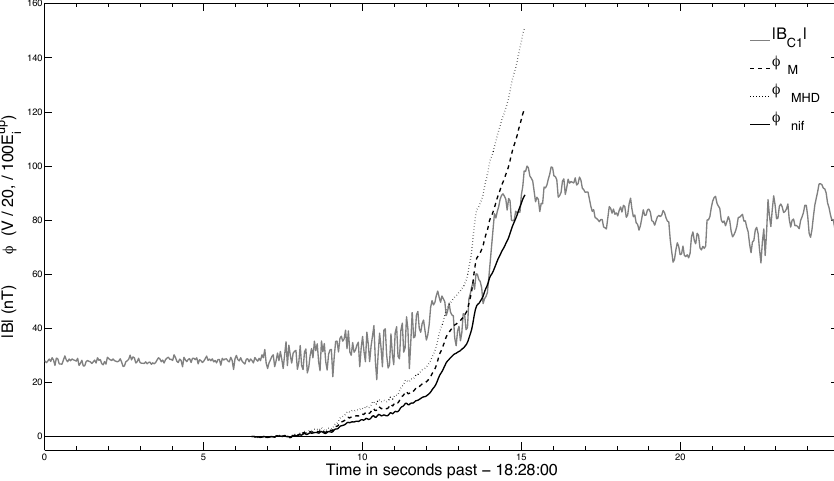
this procedure is that the direction of the shock normal is not almost perpendicular to the axis of the spacecraft spin